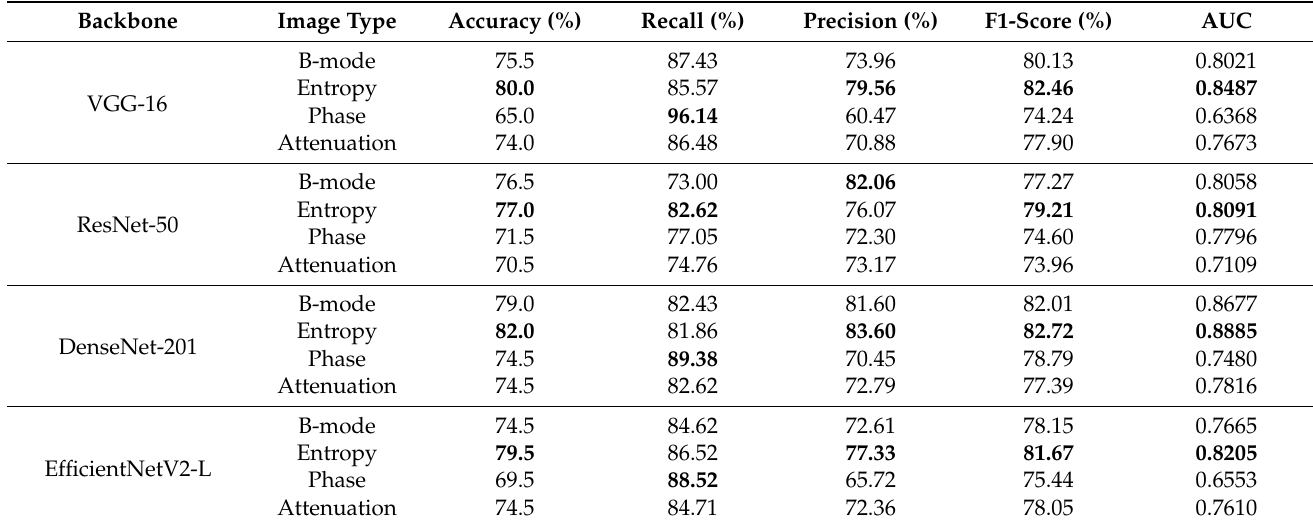
Table 1. Classification performances of various CNNs using individual parametric